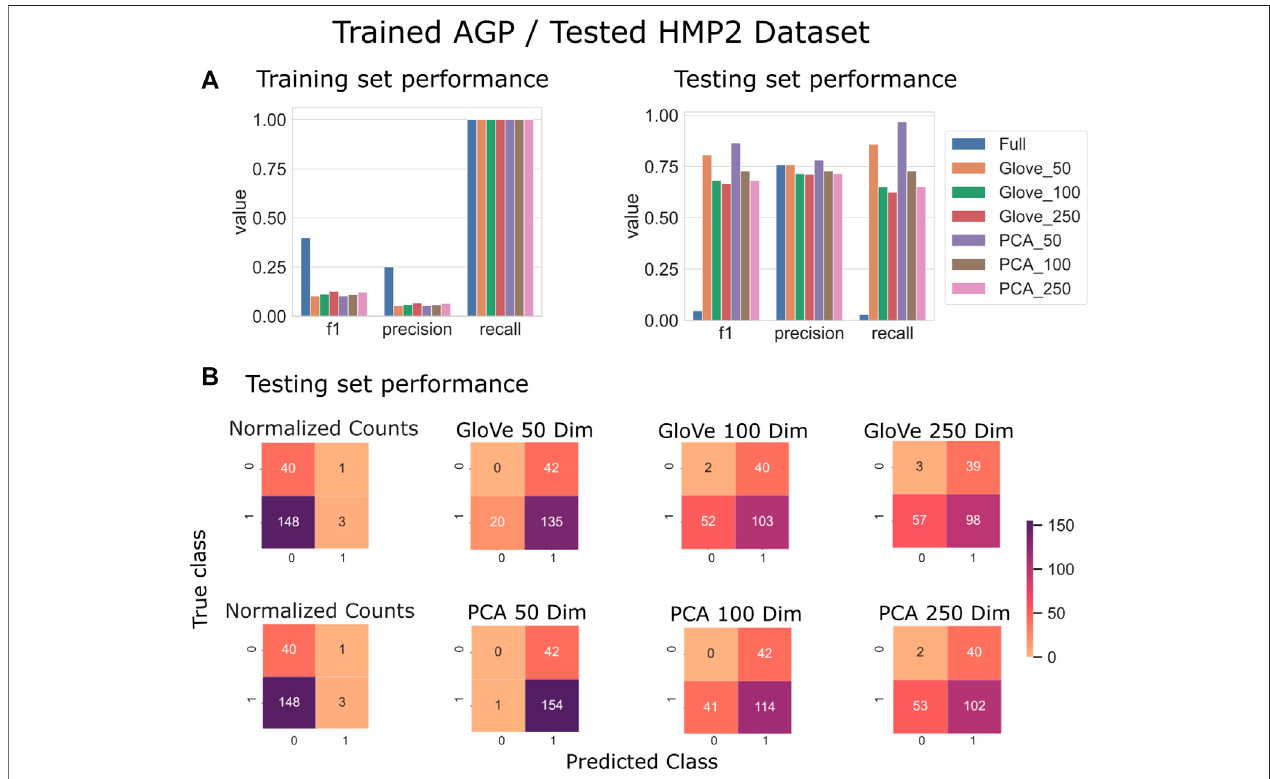
FIGURE3| PredictingIBD:ModeltrainedonAGPdataandtestedonHMP2data. (A) :ModelsbuiltusingGloVeembeddeddata,PCAembeddeddata(50,100,or 250dimensions),ornormalizedASVcountsperformanceontrainingandtestingsets. (B) :Confusionmatricesshowingthedistributionofcorrecttopredictedclasseson the testing dataset.